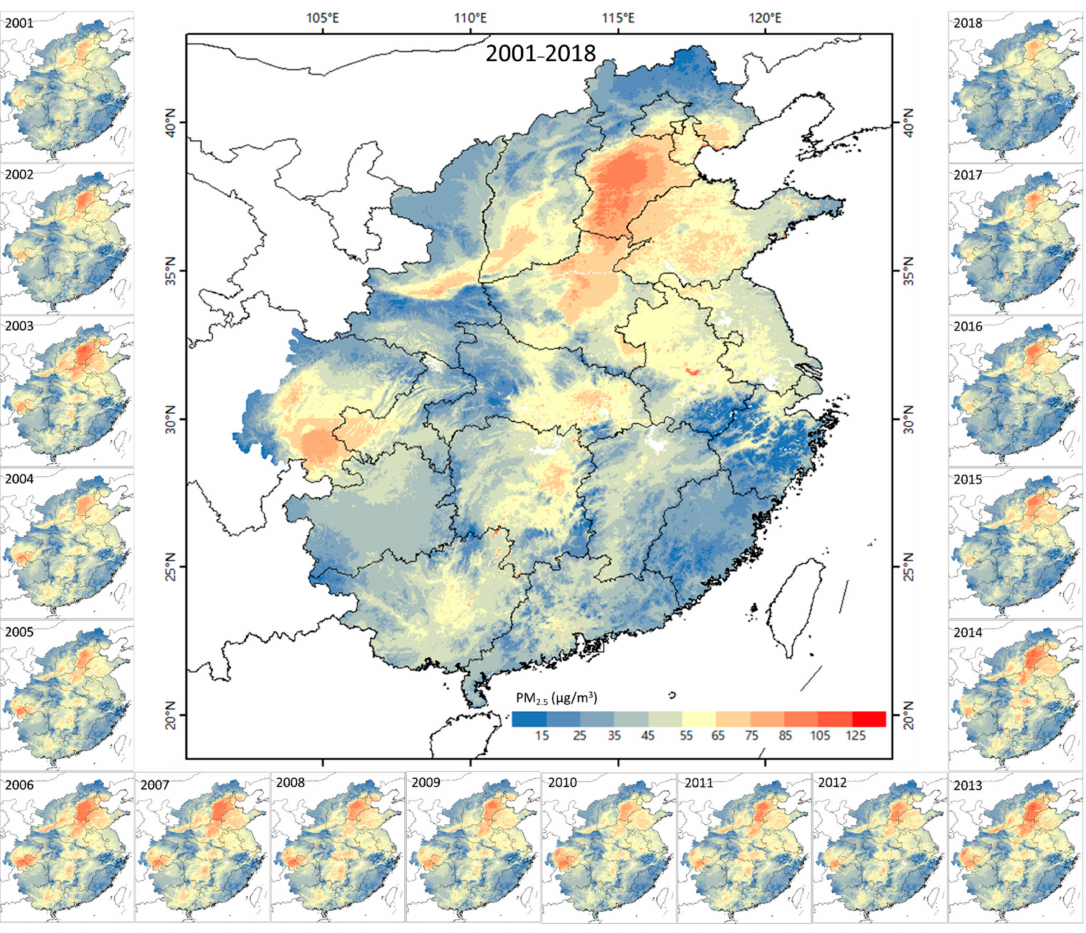
Figure 2. Spatial maps of 1-km PM 2.5 concentrations over eastern China in